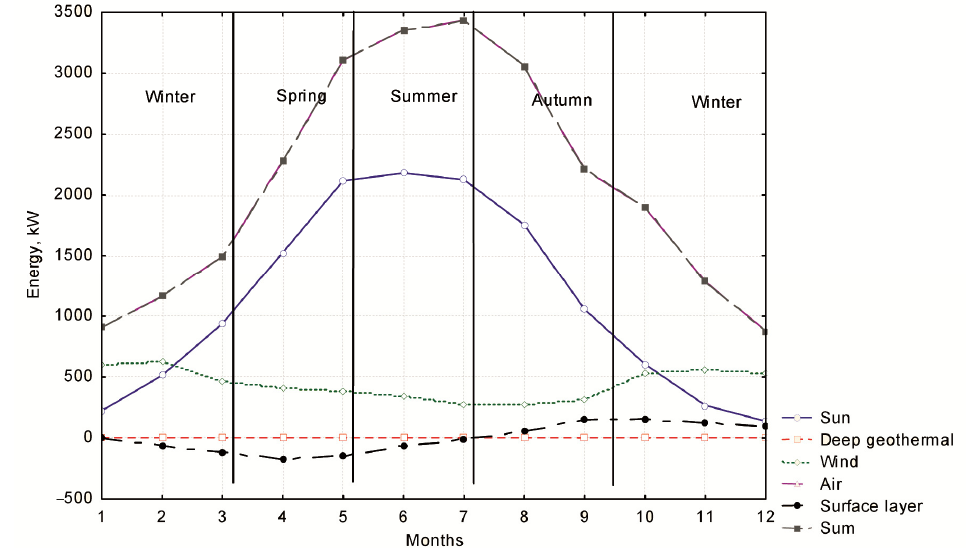
Fig. 6. Year preliminary division into seasons and overall dynamics of RE flows of selected building